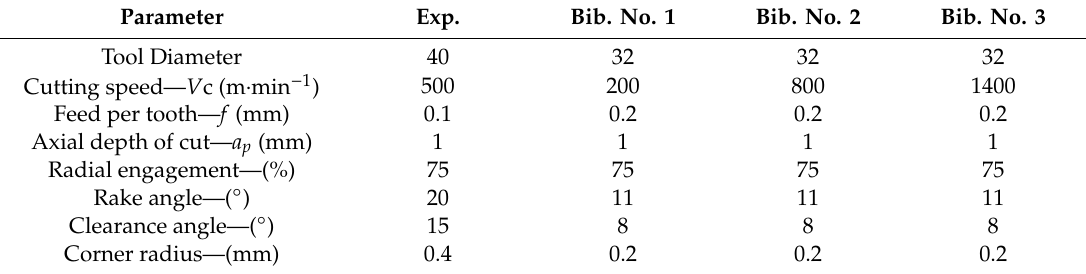
Table 3. Cutting parameters of MIRS measured in Al7050-T7451 face milled surfaces by incremental hole drilling.